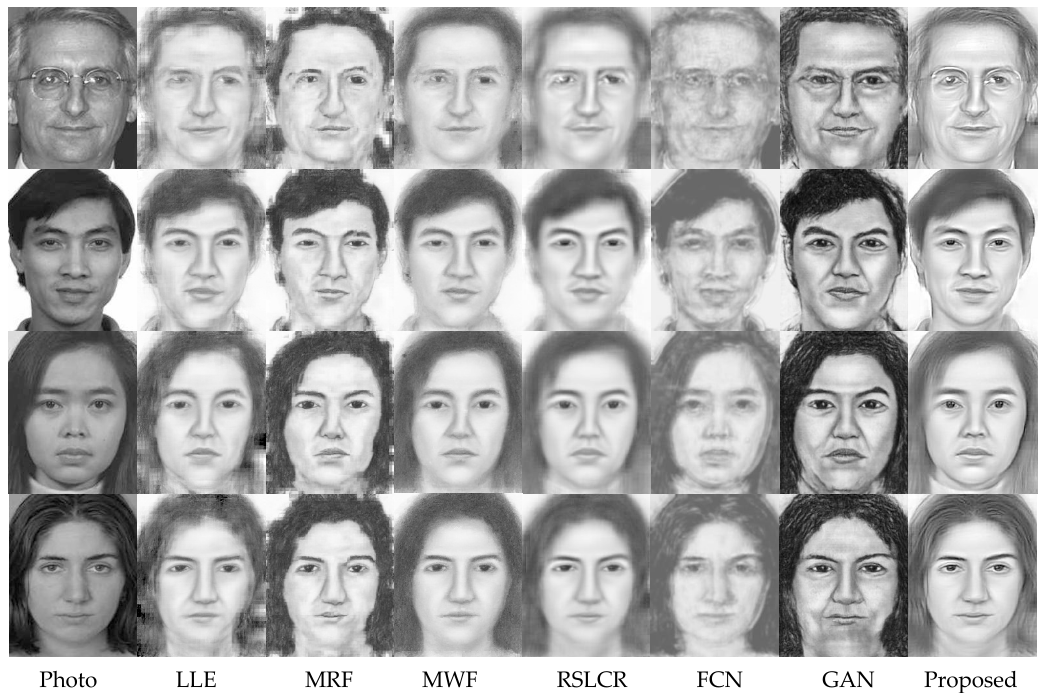
Figure 5. Synthesized sketches on the CUFSF dataset by LLE [7], MRF [9], MWF [10], RSLCR [13], FCN [15], GAN [17], and the proposed method, respectively.